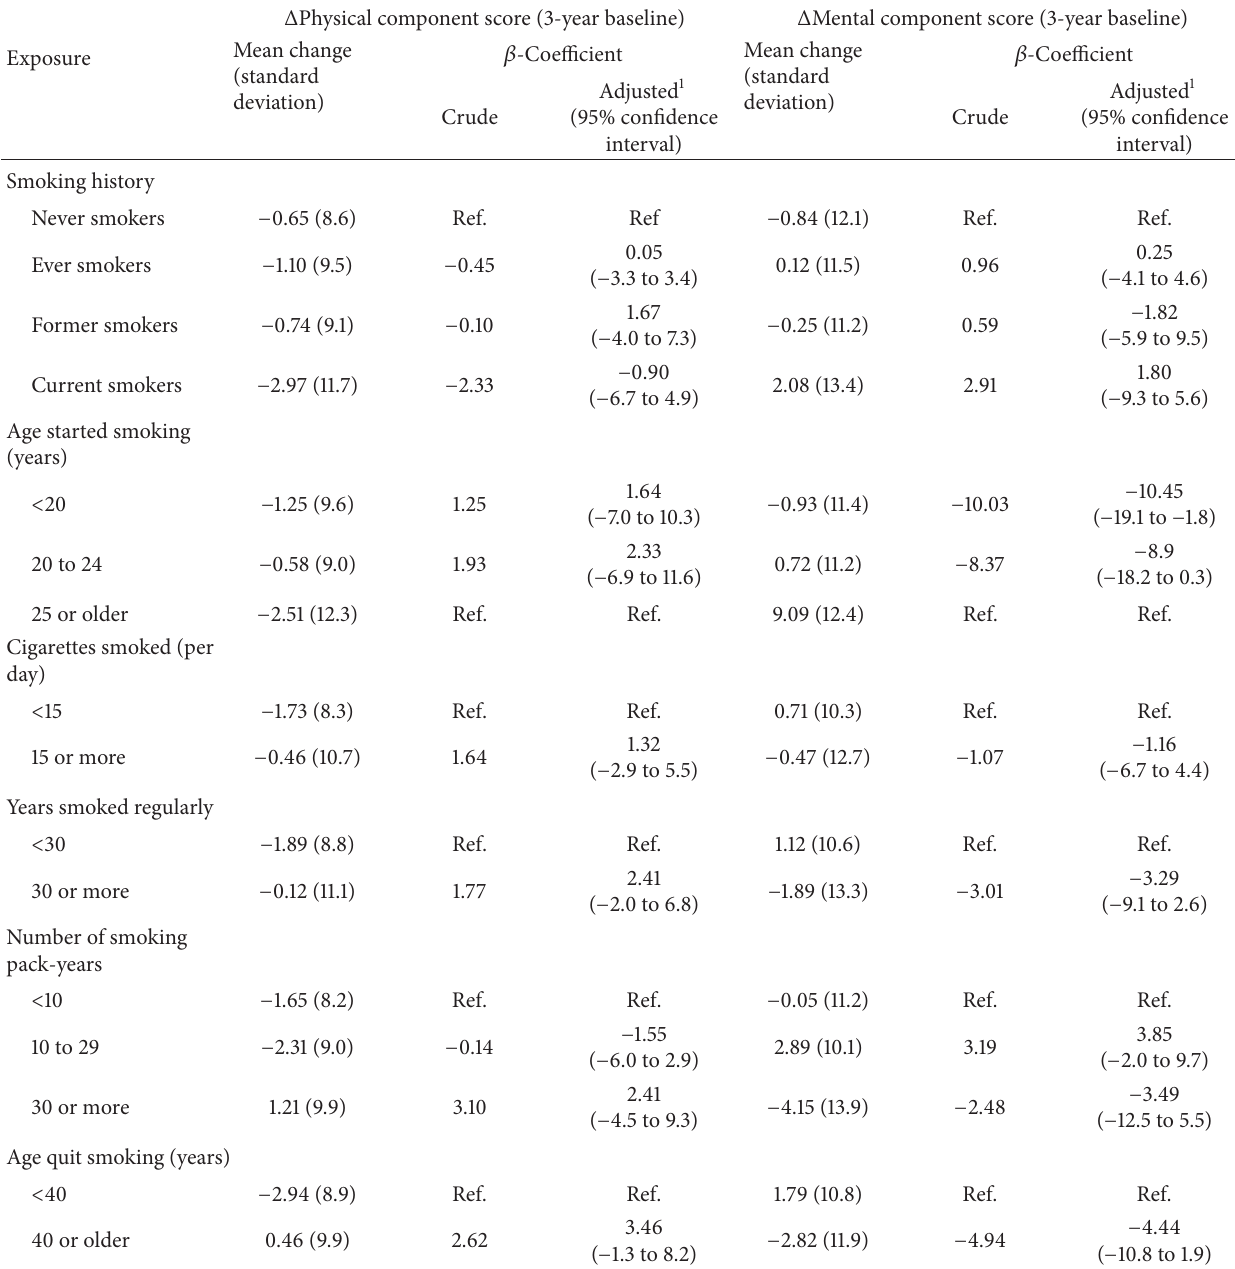
Table 2: Association between smoking status and change in health-related quality of life measures over 3 years among postmenopausal women with multiple sclerosis in the Women’s Health Initiative Observational